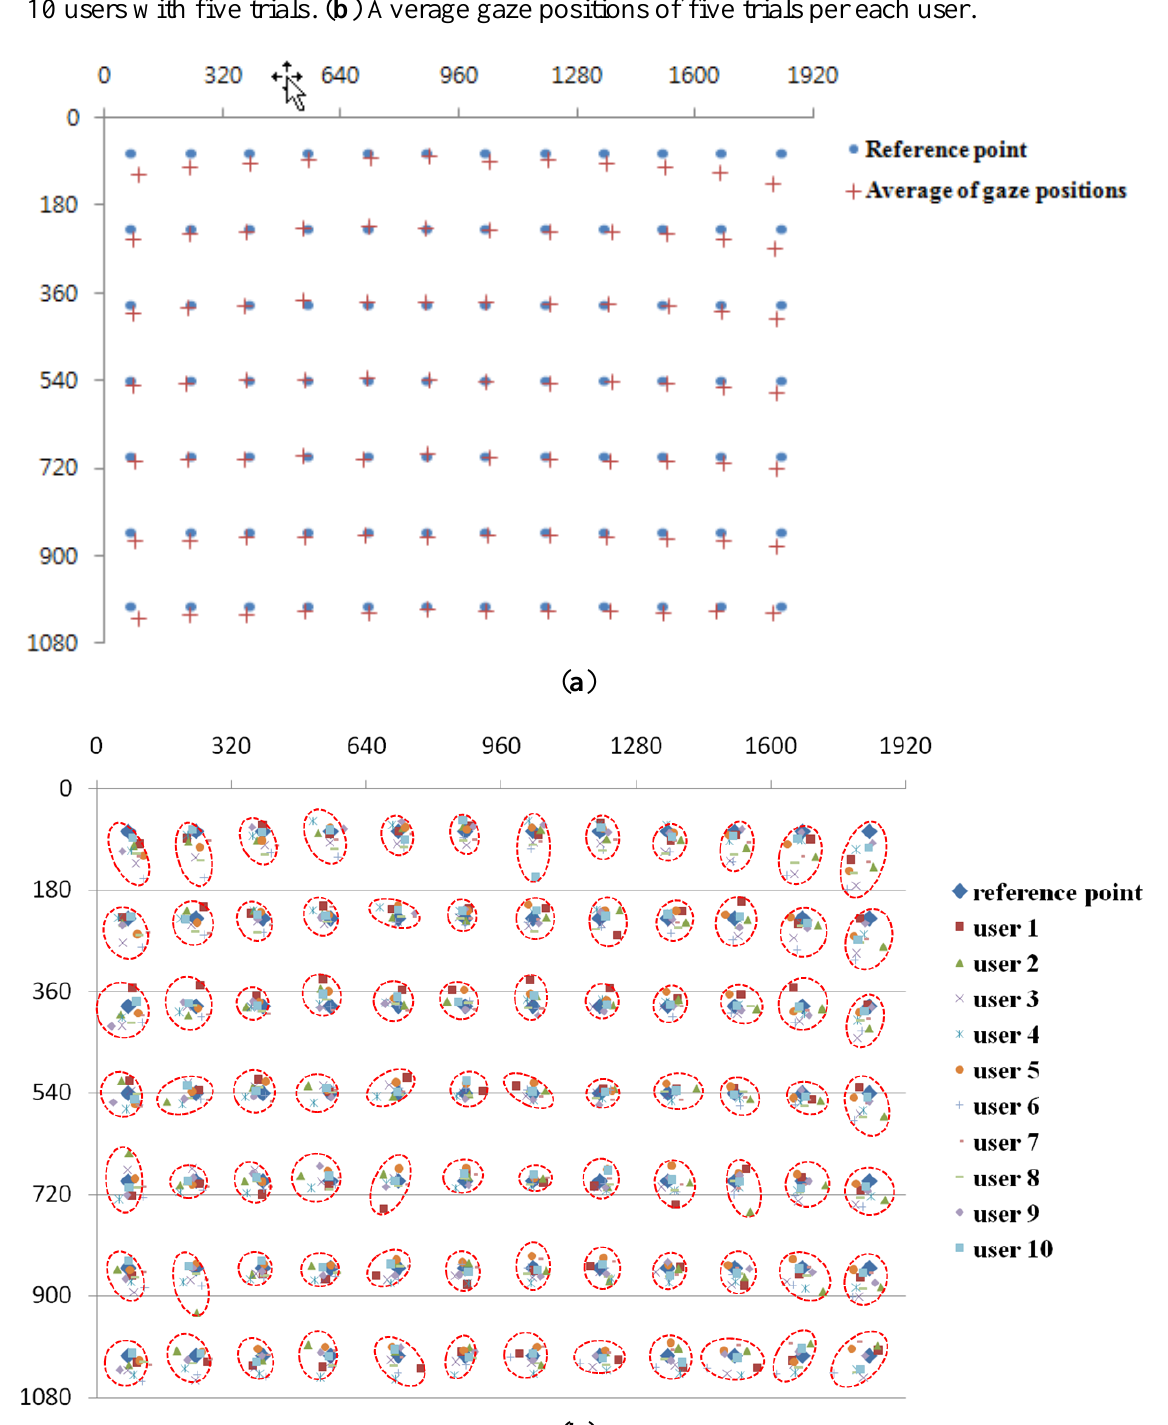
Figure 13. Results of average gaze positions of 10 users. ( a ) Average gaze positions of 10 users with five trials. ( b ) Average gaze positions of five trials per each